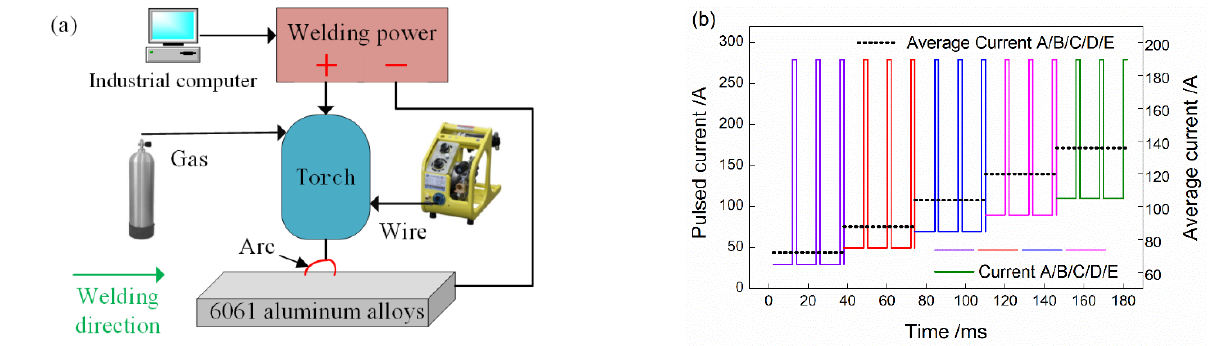
Table 1. Chemical compositions of AA6061 and ER4047 (wt%).